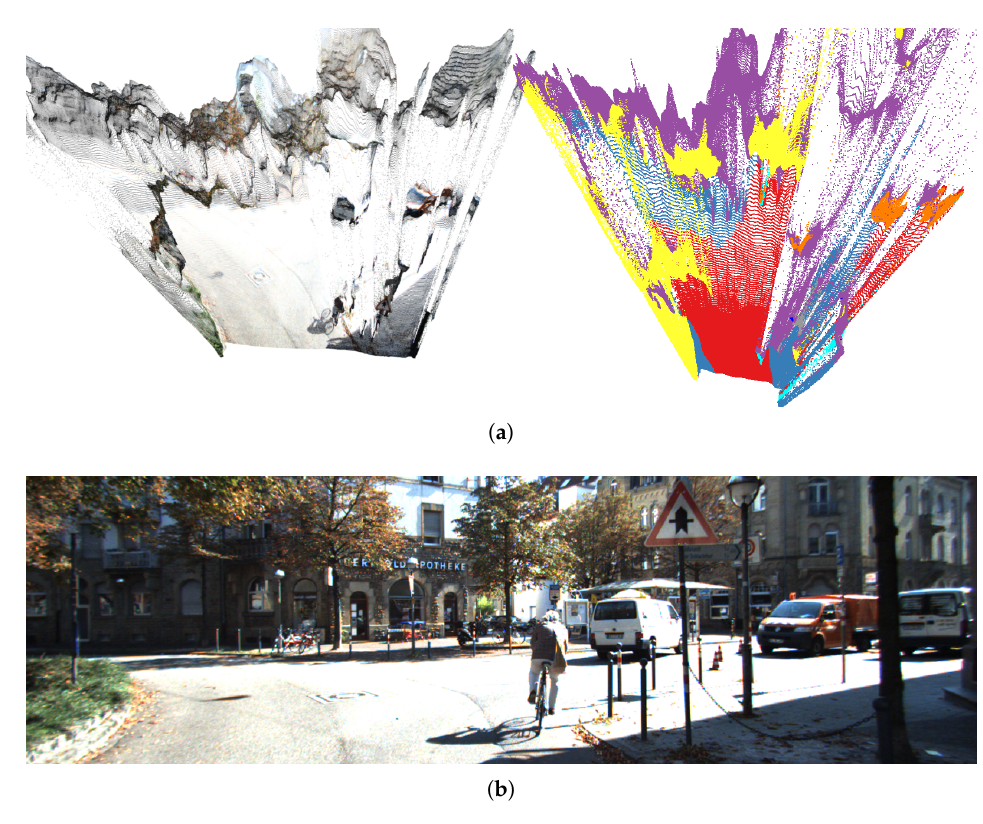
Figure 11. The trajectory for the 2011_09_26_drive_0005 sequence. Yellow points are the positions as measured by the GPS, red points are the position estimates of our proposal, blue points are the position estimates of RLE without the new proposal. The red car is associated with the parked truck visible in the overlaid camera frame (white arrow). As the reader will notice, the red sequence of dots matches the GPS after a short period of uncertainty while our previous work becomes lost after drifting (subsequent blue points were outside of the acceptable distance from the main road).